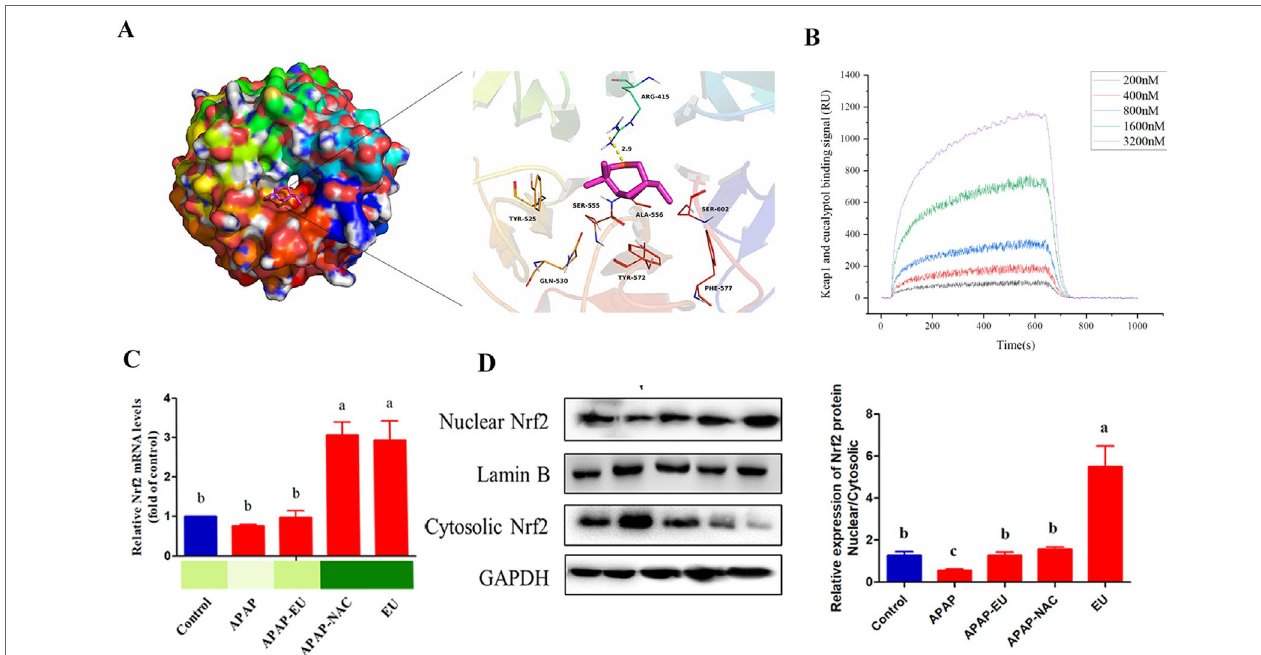
FIGURE 7 | Effect of eucalyptol on nuclear factor erythroid 2-related factor 2 (Nrf2) expression. (A) eucalyptol docking with Keap1; (B) binding signal of Keap1 and eucalyptol (RU); (C) mRNA levels of Nrf2; (D) protein levels of Nrf2 in nuclear and cytosolic. a, b, c different letters indicate statistically different groups ( p <